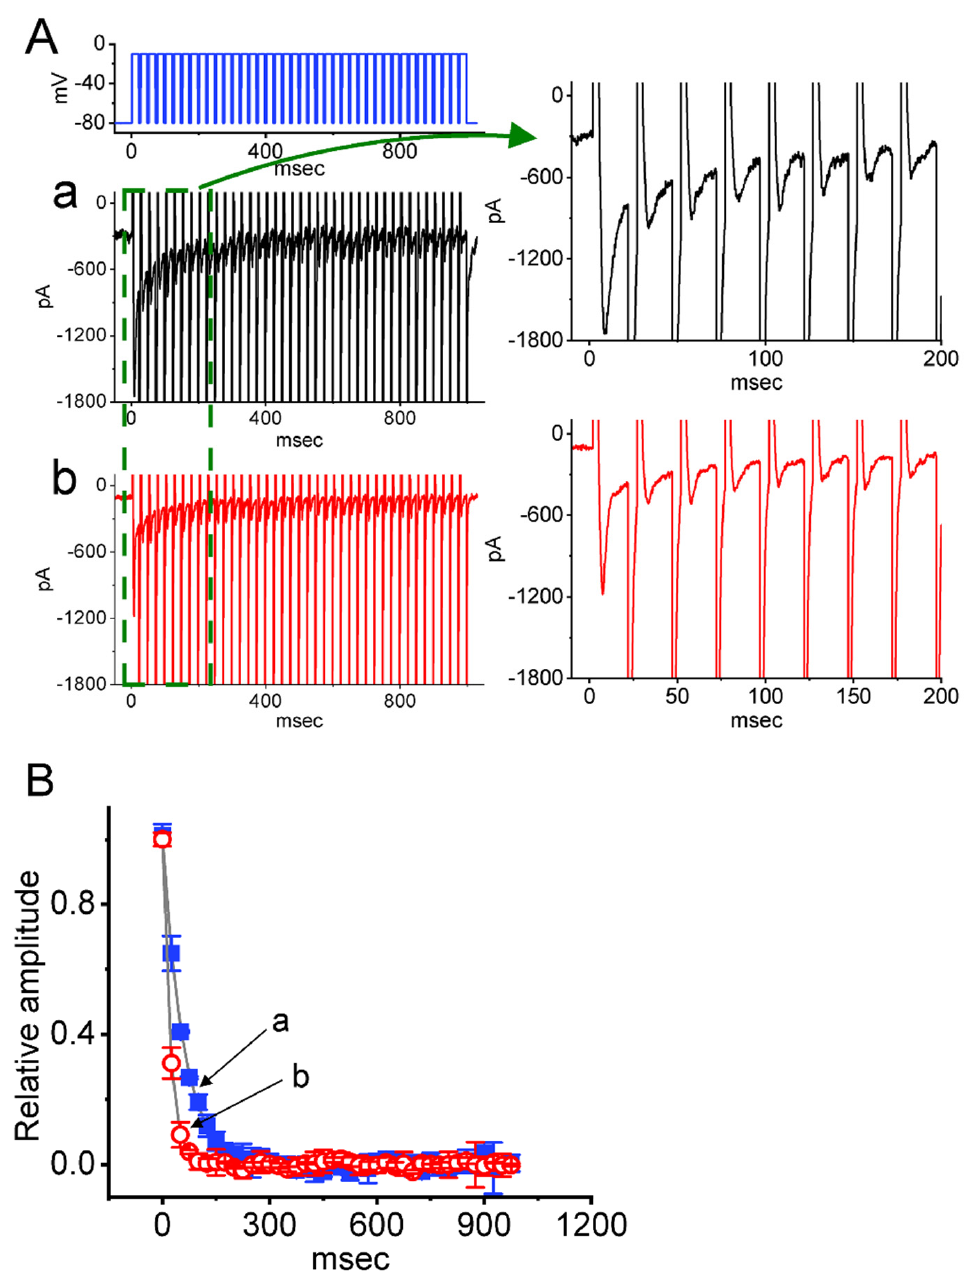
Figure 6. Effect of CBZ on I Na(T) evoked by a train of depolarizing pulses in Neuro-2a cells. The train applied consists of 40–20 ms pulses (stepped to − 10 mV) separated by 5 ms intervals at − 80 mV for a duration of 1 s. ( A ) Representative current traces were acquired in the control period ( a , CBZ was not present, black color) and during cell exposure to 30 µ M CBZ ( b , red color). The voltage clamp protocol is illustrated in the uppermost part. To provide a single I Na trace, the right side of ( A ) shows the expanded records from a broken green box on the left side. ( B ) The relationship of I Na(T) versus the pulse train duration in the absence (a, filled blue squares) and presence (b, open red circles) of 30 µ M CBZ (mean ± SEM; n = 7 for each point). The continuous smooth gray lines over which the data points are overlaid are fitted by a single exponential. Notably, cell exposure to CBZ can enhance the time course of I Na(T) inactivation activated in response to a train of depolarizing command voltages. The analysis was made by one way ANOVA (F value = 5.9, p < 0.05).